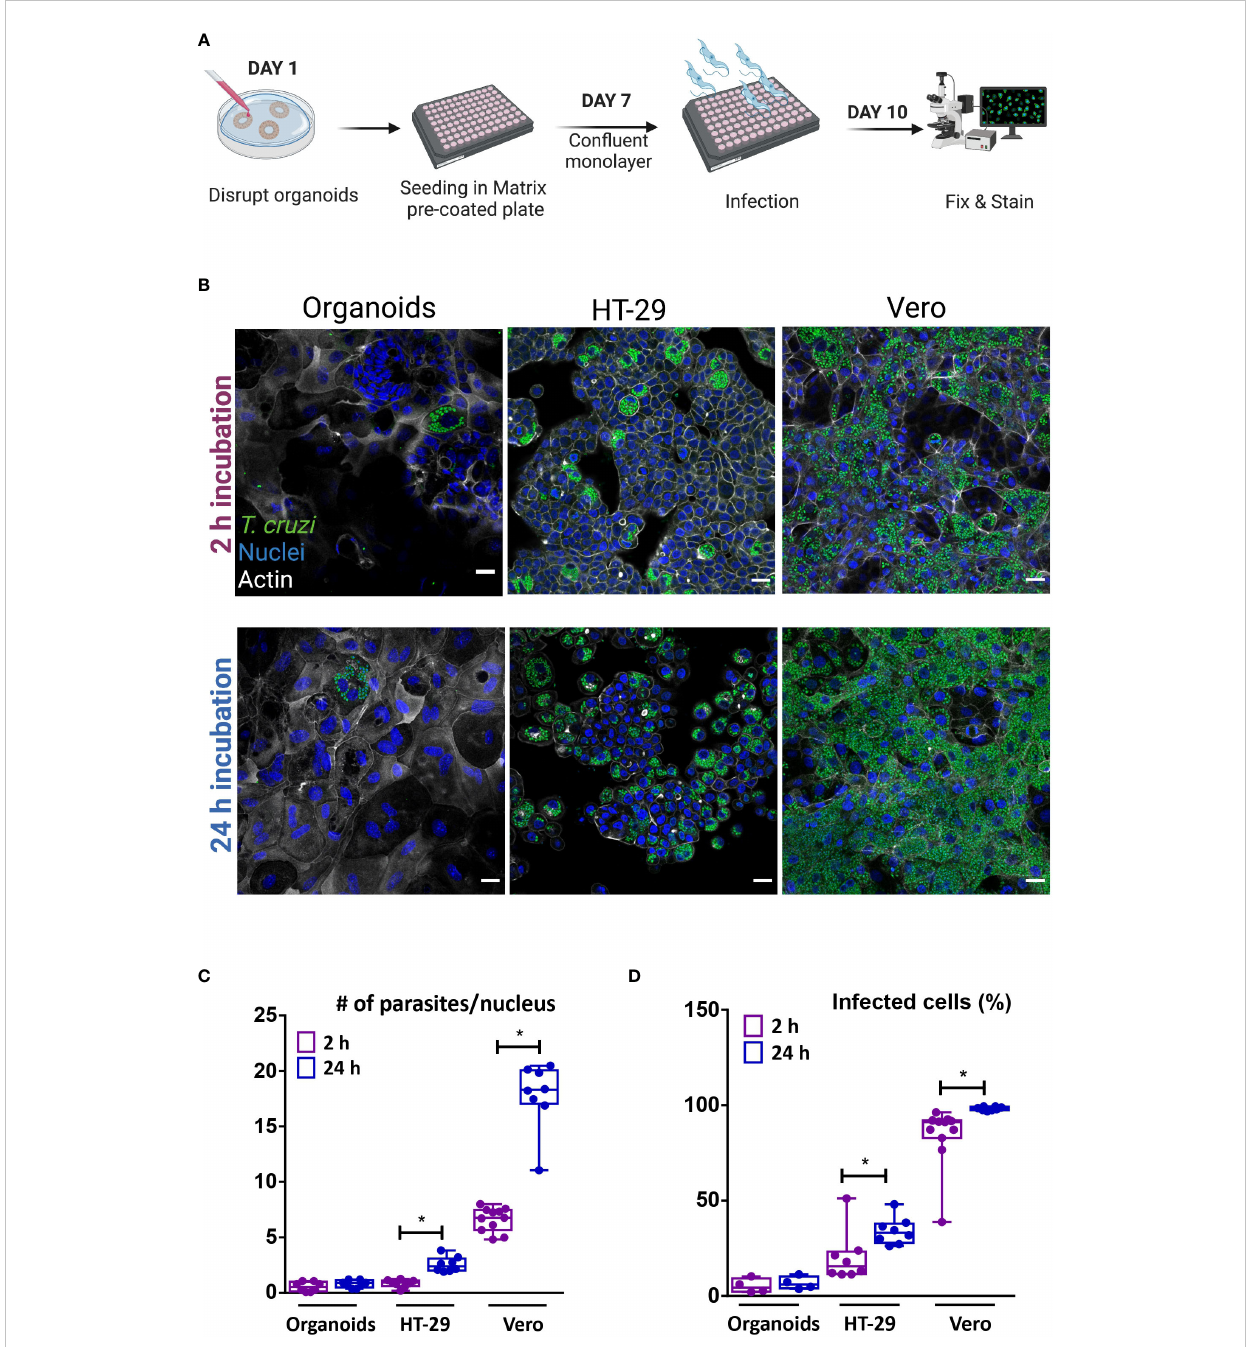
FIGURE 5 Apical organoid and cell-line infection by T cruzi . (A) Schematic representation of the infection protocol. Vero, HT-29 cells and murine colon-organoid derived cells were seeded as monolayers. After reaching con fl uence, cells were incubated with the parasites for 2 h or 24 h at 37°C and further incubated at 37°C for 72 h. Created with BioRender (agreement number WV2506JDUP) (B) Representative images of 2D infected cells (MOI 1:15). (C) Number of intracellular parasites per host-cell nucleus over a 72 h period of infection. (D) Quanti fi cation of the percentage of cells infected with at least one parasite. Infection rate was improved with longer incubation time for HT-29 and Vero cells, while organoid-derived monolayers showed similar parasite load, regardless of time exposure. Data from one representative experiment out of 2 independent experiments (different organoid lines per experiment). Data are expressed as median and interquartile range and compared using Mann-Whitney test (n = 8), * p <0.05. Scale bar: 25 µm. Nuclei (blue): methyl green staining, T. cruzi (green): anti-trypanothione reductase immune-staining, and Actin (white): phalloidin Texas Red